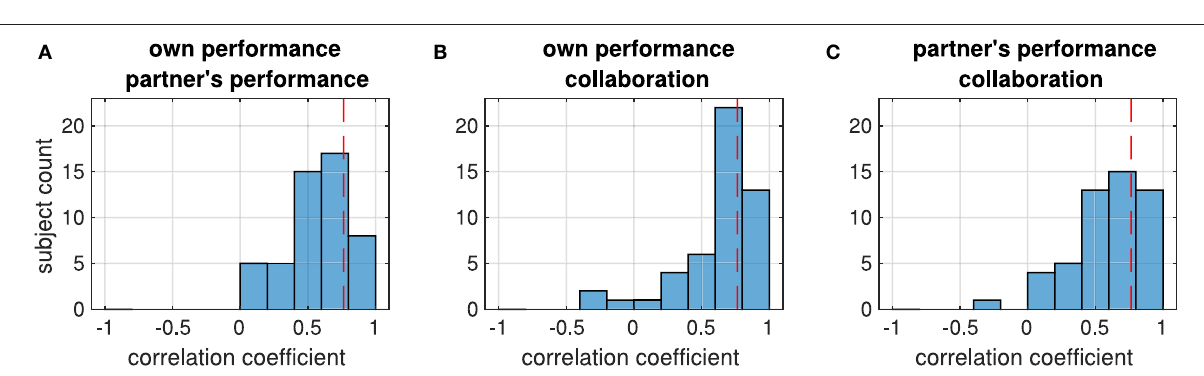
FIGURE 4 | Distribution of correlation coefficients between the ratings (printed above each histogram) from each subject. Red dashed lines mark the strength beyond which correlations are significant ( p < 0.05, FDR-corrected). The four panels show the distribution of correlations between (A) ratings of the own and the partner’s performance on the own axis (collaborative condition), (B) the partner’s performance rating and the tracking error on the partner’s axis, (C) ratings of collaboration and the Euclidean tracking error, (D) own performance rating and tracking error on the own axis (individual condition).